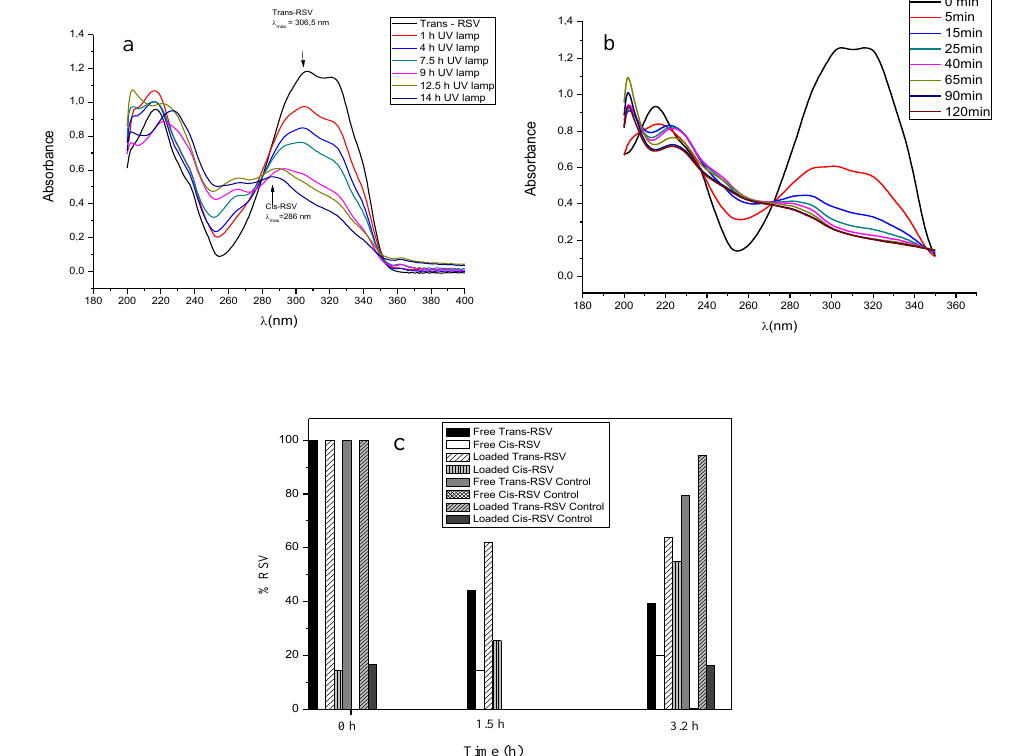
Figure 5. UV-visible spectra of isomerization and degradation of RSV under UV light exposure in ( a ) ethanol and ( b ) PBS (50 mM), pH 7.4. ( c ) Photodegradation study in solid: Percentage of the decay of trans -RSV, free and encapsulated, in microcapsules after UV light exposure (254 nm).